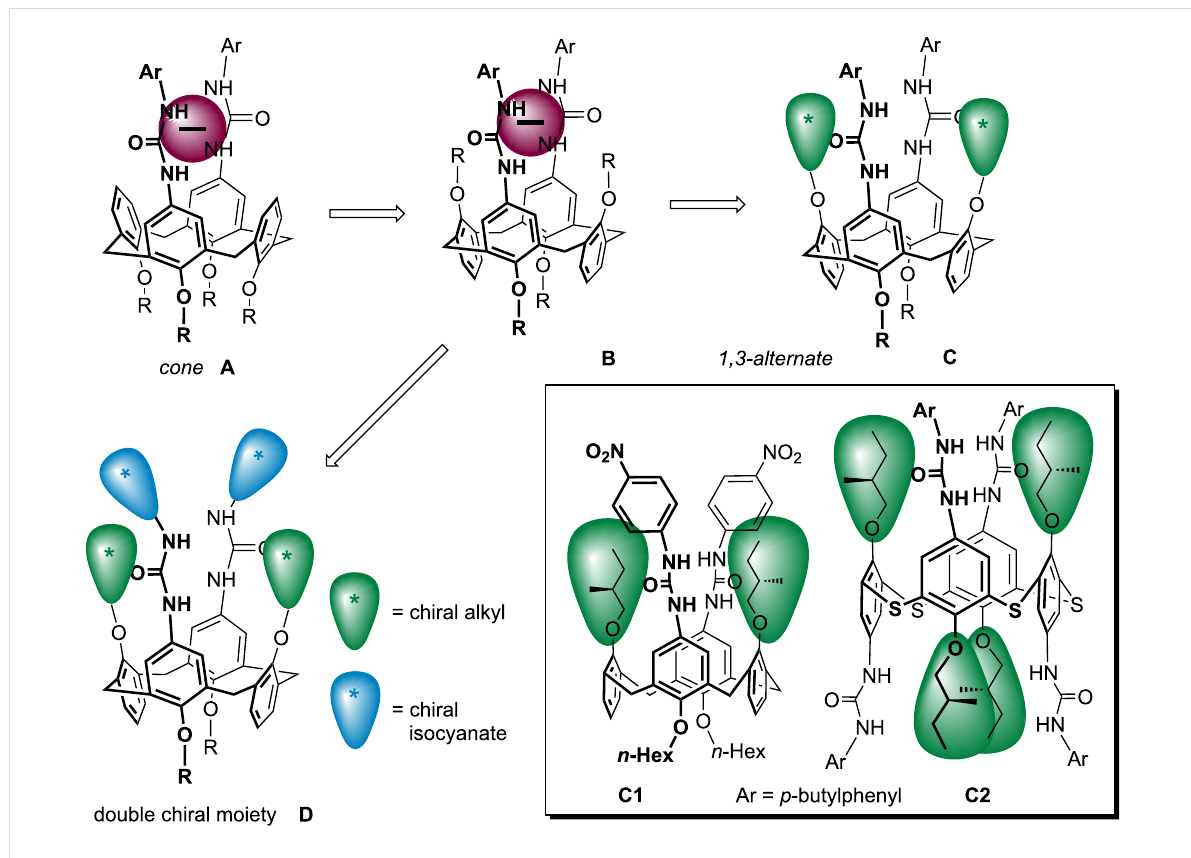
Figure 1: Design of chiral calix[4]arene-based receptors for anions.